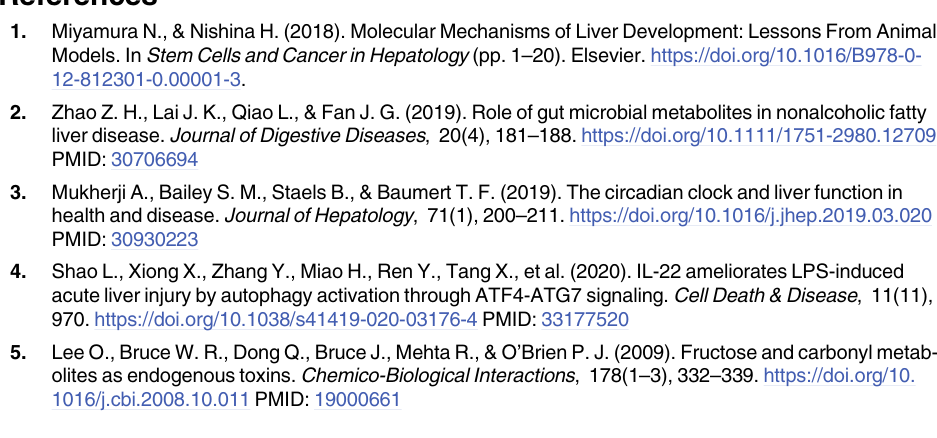
SYBR ™ Green dye–based PCR amplification and detection. Data of six technical repetitions for each experimental group. HE: Healthy untreated HepG2 cells; ERS: Endoplasmic reticulum- stressed cells; ERS+MSI: Groups pre-treated with MSI-1436 compound before inducing ERS. S1 Fig. Fig_Raw_Gels images for XBP1 splicing analysis: Original uncropped gel images for XBP1 splicing obtained from agarose gel electrophoresis analysis. Un-spliced XBP1: 281bp, spliced: 255bp. Bands were quantified using Image Studio Lite software (LI-COR Bio- sciences, USA). HE: Healthy untreated HepG2 cells; ERS: Endoplasmic reticulum-stressed cells; ERS+MSI: Groups pre-treated with MSI-1436 compound before inducing